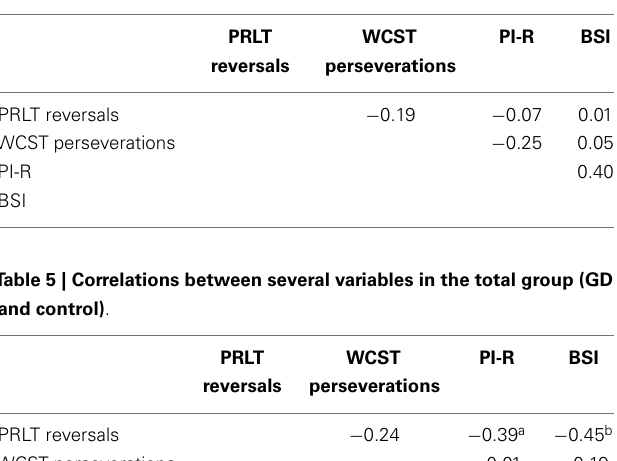
Table 4 | Correlations between several variables in the control group .